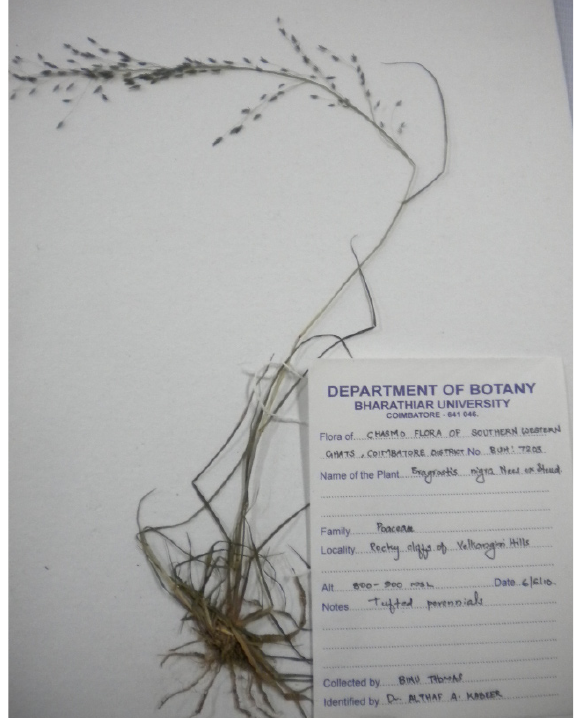
Image 18. Eragrostis nigra Nees ex Steud.